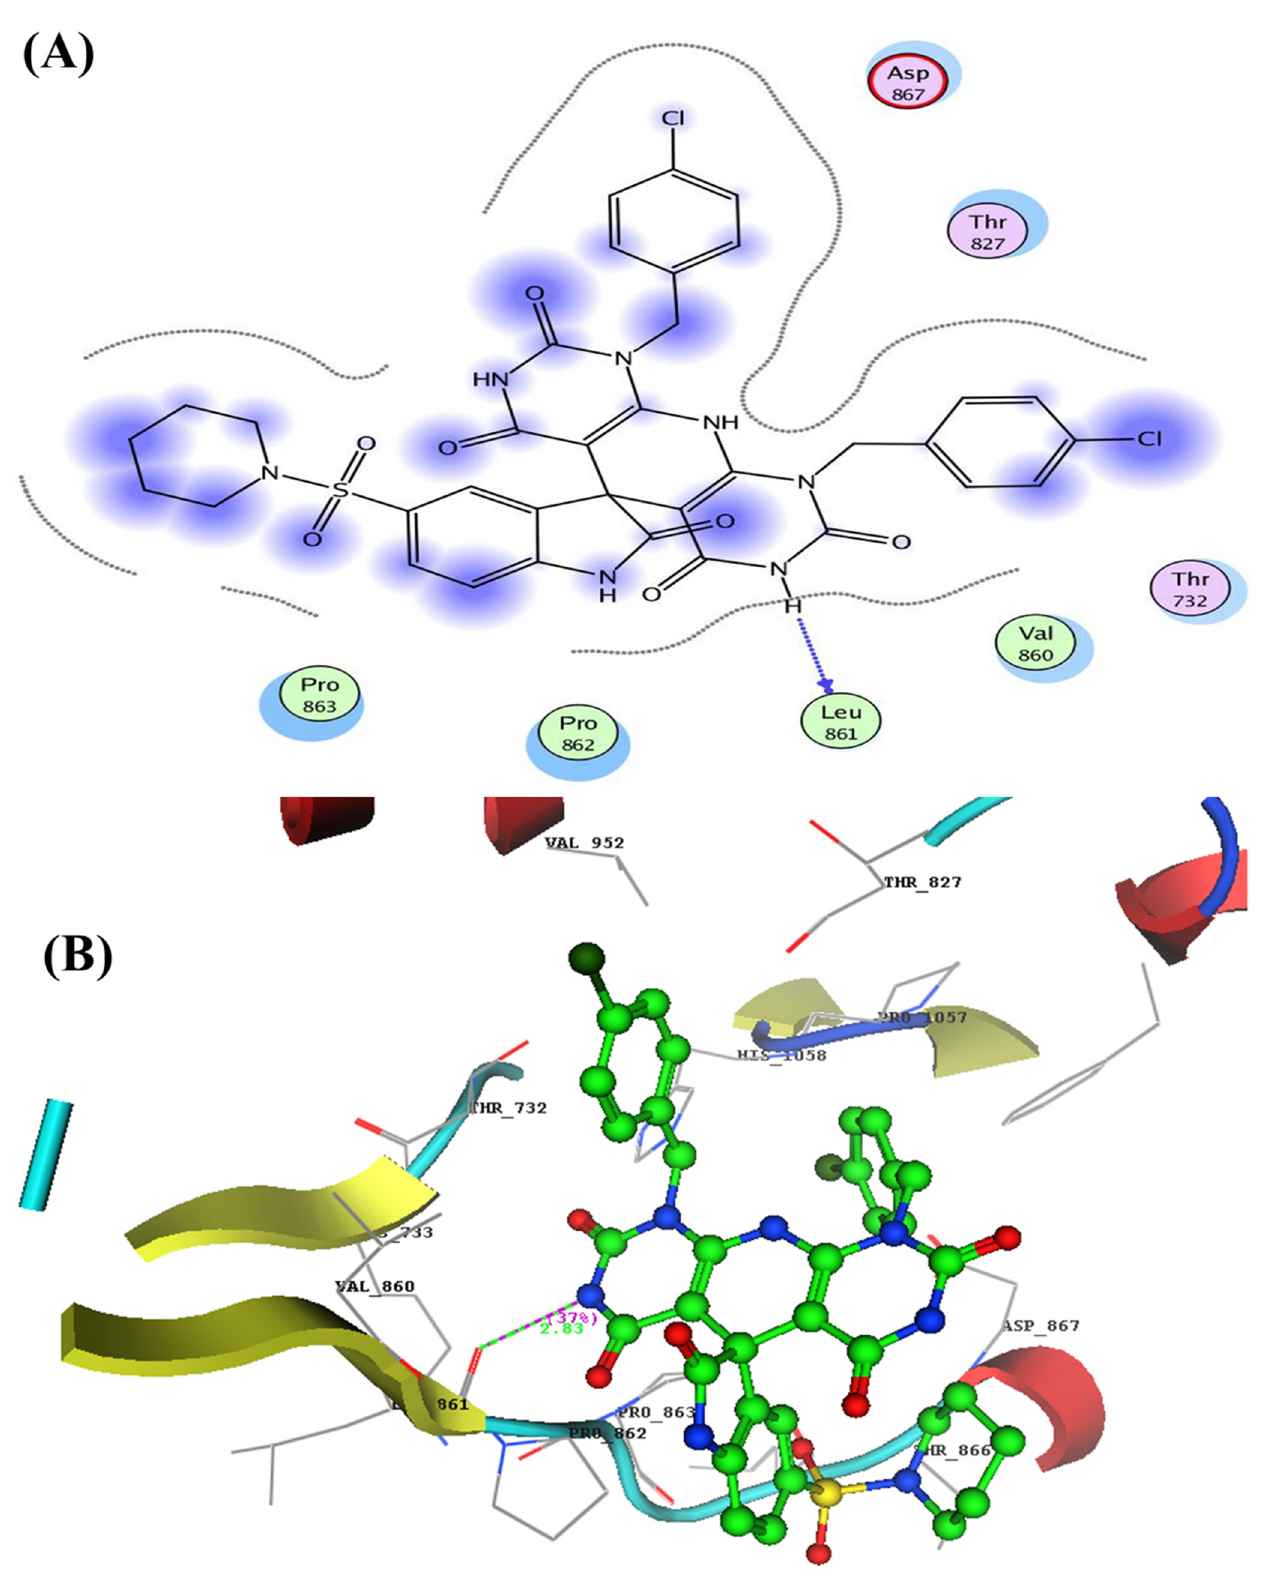
Figure 9. ( A ) 2D and ( B ) 3D structures of compound 4d inside the active site of spike glycoprotein (SGp) (PDB: 6VXX)